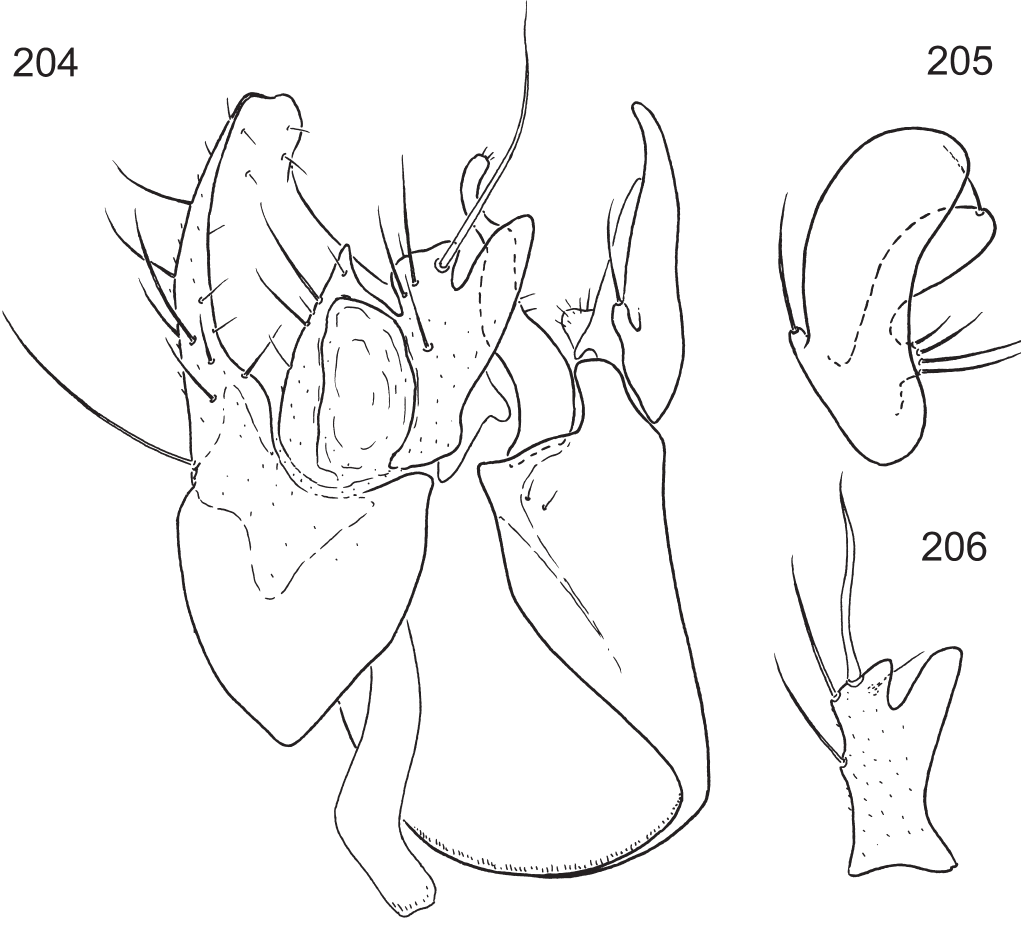
Figs 204-206. Stilpon arcuatum sp. nov., ♂ terminalia. 204 . epandrium with cerci, dorsal view. 205 . left surstylus, lateral view. 206 . left cercus, lateral